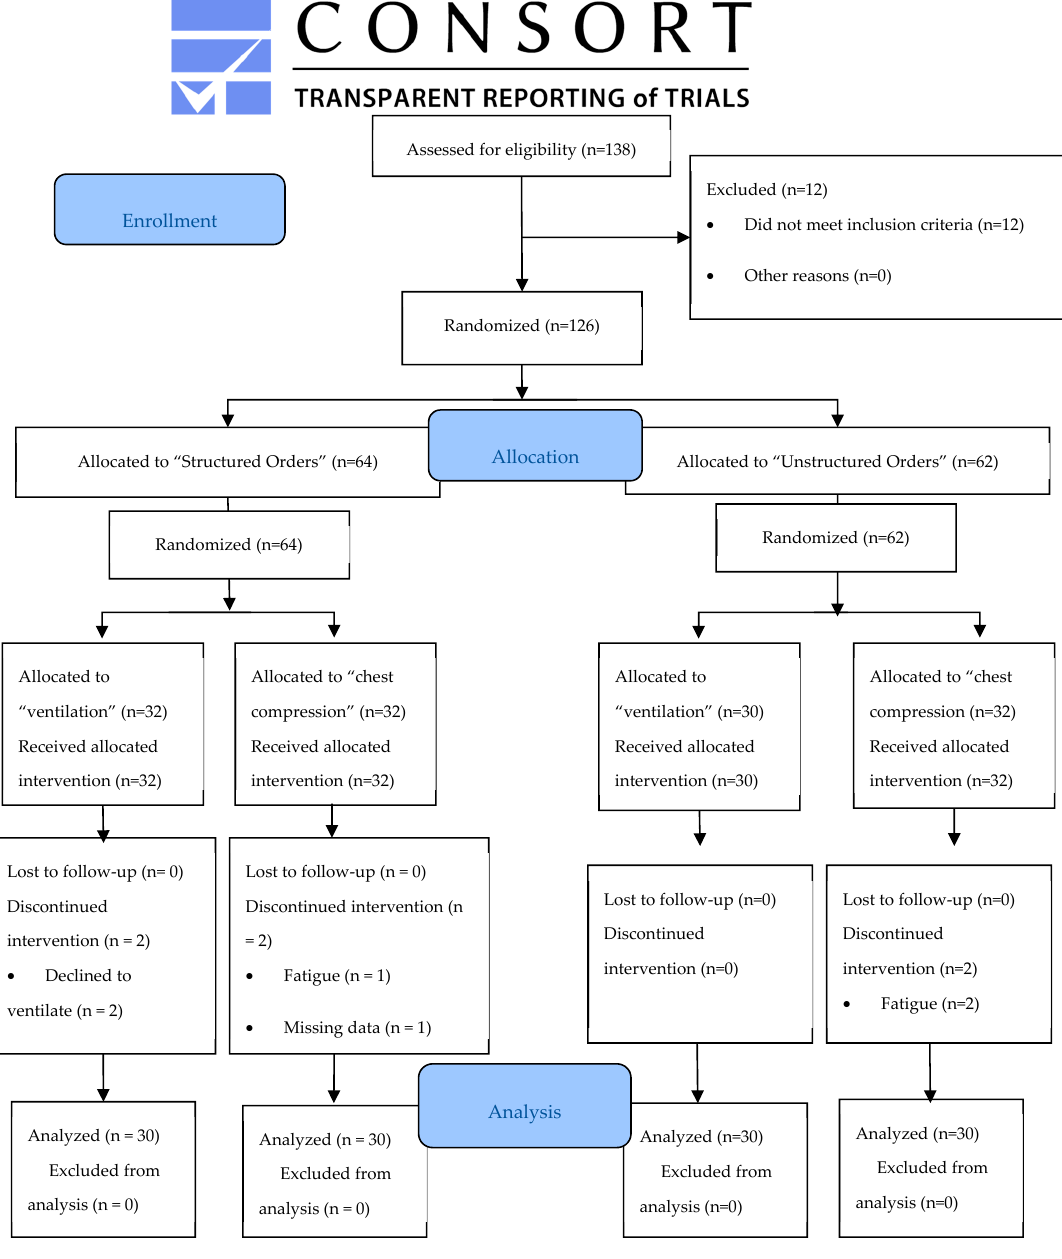
Figure 1. Study CONSORT flow diagram.